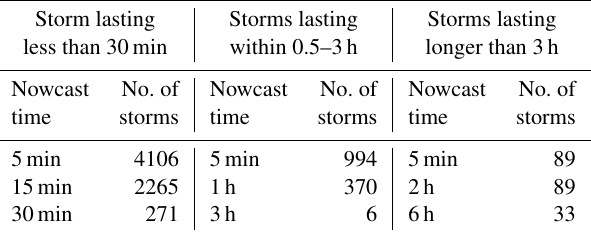
Table 2. The selected storm durations and nowcast times for the performance calculation of the deterministic and probabilistic now- casts and the respective number of storms for each